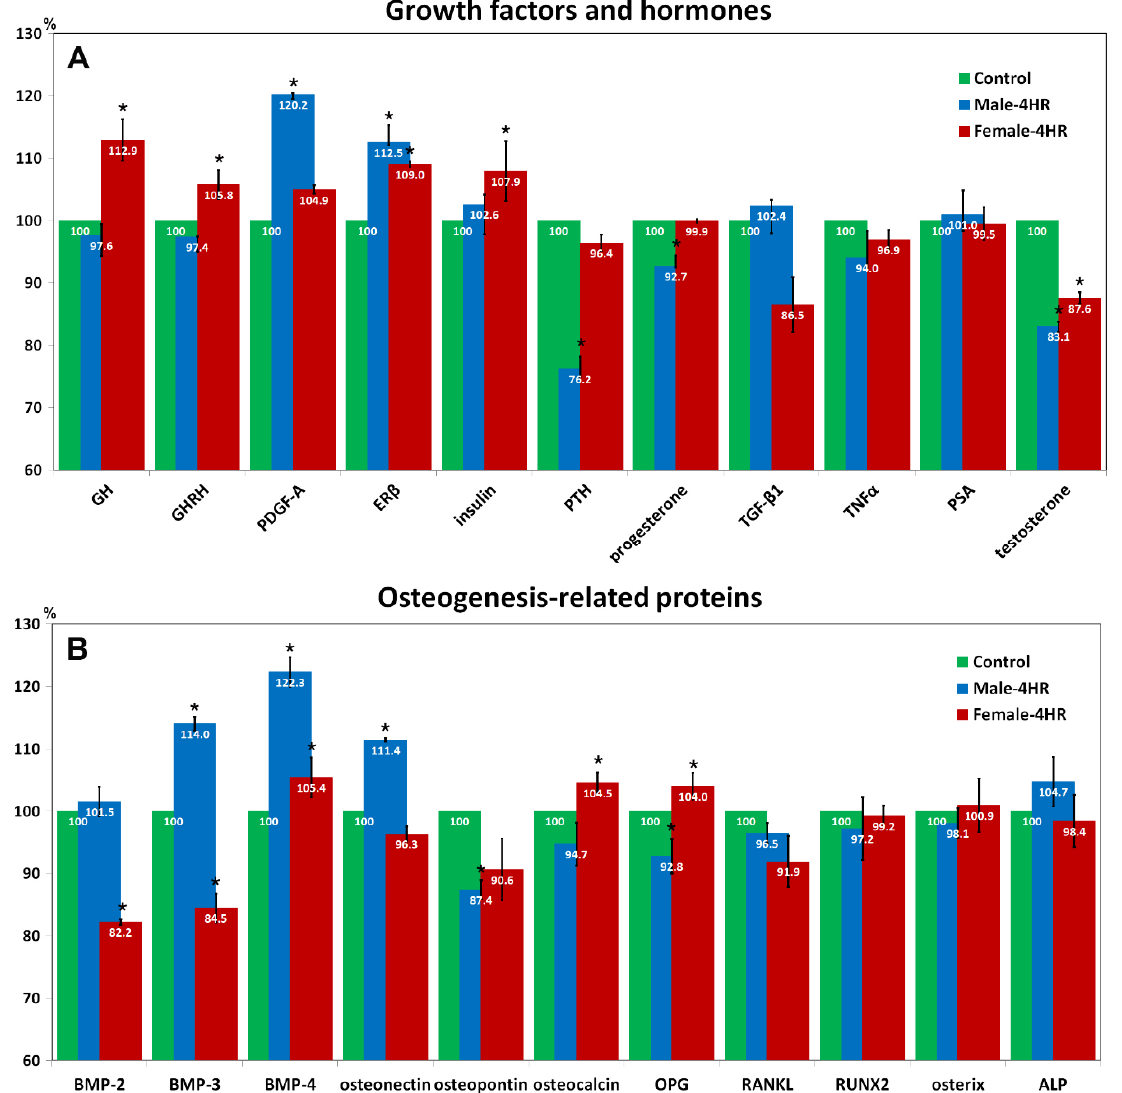
Figure 4. IP-HPLC analysis. Expression of growth factors, hormones, and osteogenesis-related proteins in the blood plasma of rats. Expression profiles of ( A ) growth factors and hormones, and ( B ) osteogenesis-related proteins. (* p < 0.05 when compared to the control). 4HR-treated male rats showed significantly decreased levels of parathyroid hormone (PTH, 23.8%), progesterone (7.3%), testosterone (16.9%), osteopontin (12.6%), and osteoprotegerin (OPG, 7.2%) compared to the untreated male rats, while 4HR-treated female rats showed increased levels of growth hormone (GH, 12.9%), growth hormone-releasing hormone (GHRH, 5.8%), insulin (7.9%), osteocalcin (4.5%), and OPG (4%) compared to untreated female rats (PDGF-A: platelet-derived growth factor-A, Er β : estrogen receptor- β , TGF- β 1: trans-forming growth factor- β 1, TNF α : tumor necrosis factor- α , PSA: prostate-specific antigen, BMP: bone morphogenic protein, RANKL: Receptor activator of NF- κ B, RUNX2: Runt-related transcription factor 2, ALP: alkaline phosphatase).